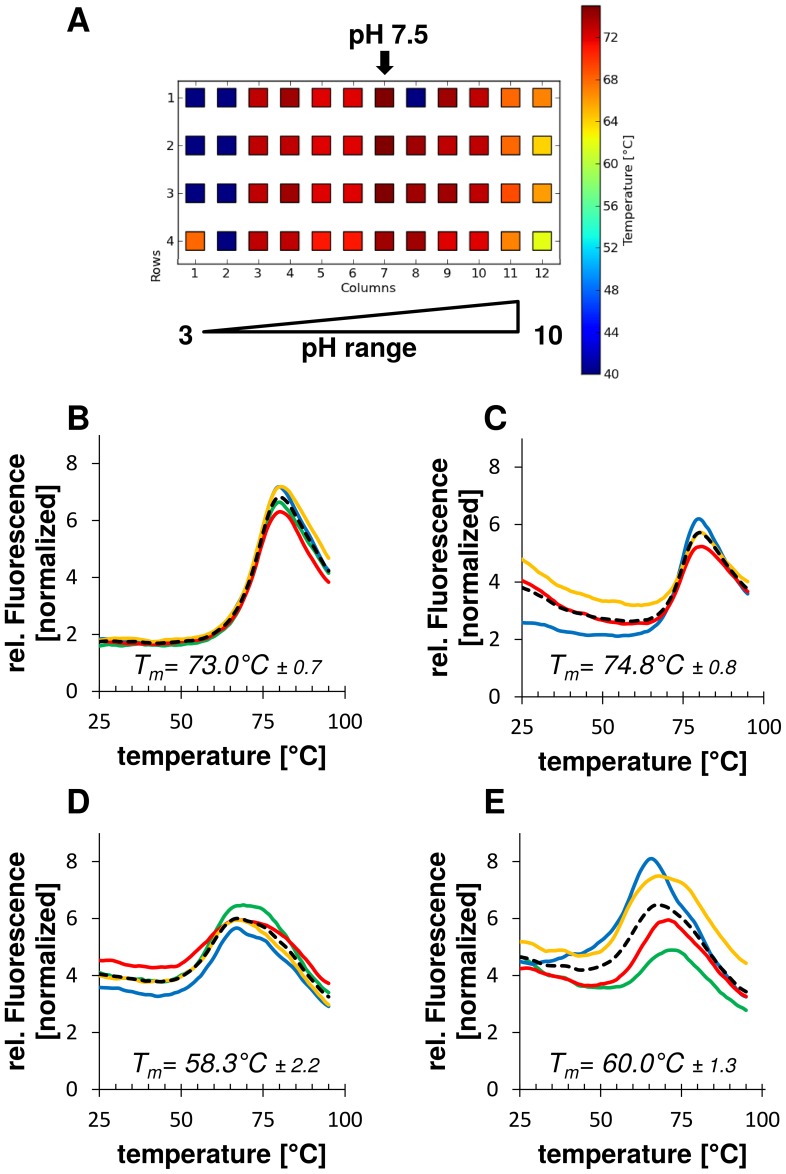
Thermofluor assay for investigating the stability of wild type and mutant hHsp90 CTD.Protein stability was analyzed in 12 different pH buffers in four independent measurements. (A) Heatmap for wild type hHsp90 CTD. Melting curves of measurements at pH 7.5 with the average T
m and standard deviation are shown below for wild type hHsp90 CTD (B), hHsp90 CTD with cold spot mutants as negative control (C), as well as hot spot alanine mutants CTDY689A/I692A/L696A (D) and CTDI688A/Y689A/I692A (E). The mean value (dotted black line) was calculated from four independent measurements (yellow, red, blue, green lines) in reaction buffer with 100 mM Tris.